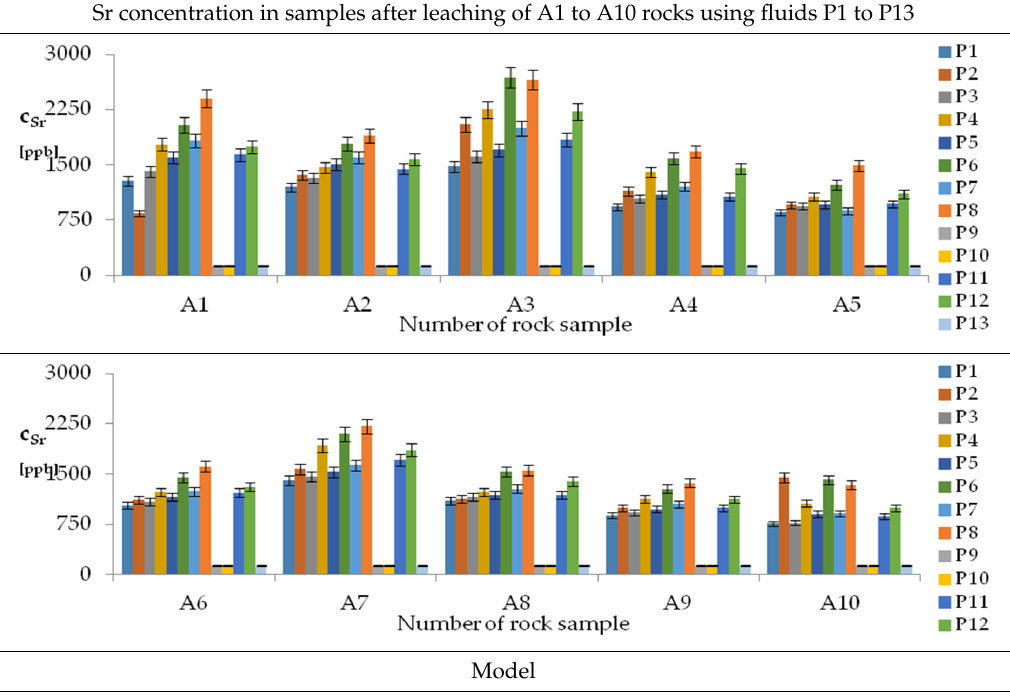
Table 7. Results of leaching samples A1 to A10 rocks using fluids P1 to P13 for Strontium (Sr). Sr concentration in samples after leaching of A1 to A10 rocks using fluids P1 to P13